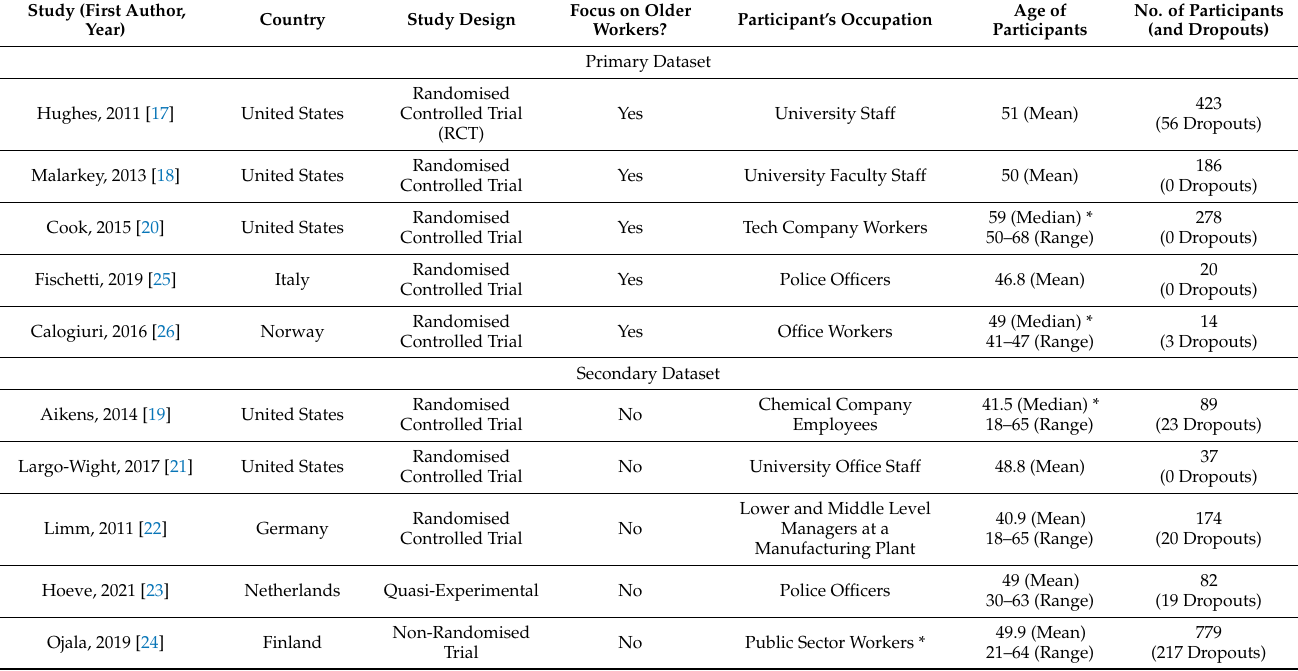
Table 4. Description of Studies.